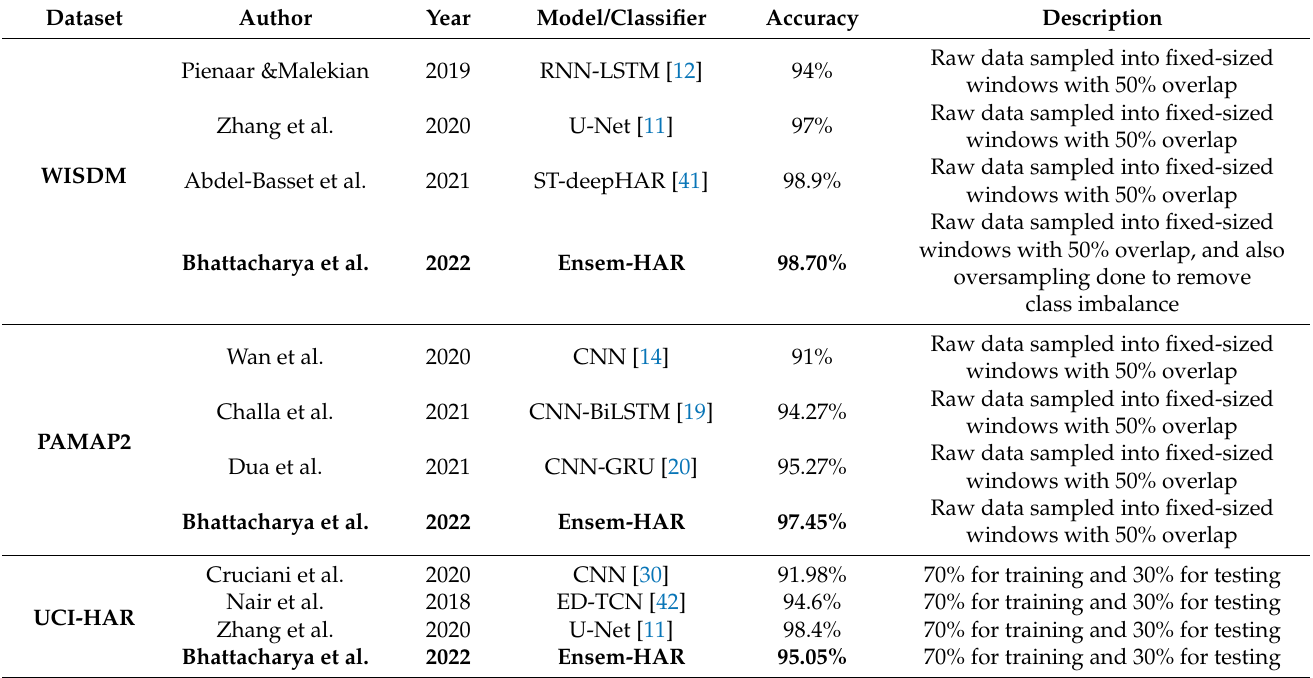
Table 6. Performance Comparison (in %) between several of the latest HAR approaches and our proposed Ensem-HAR